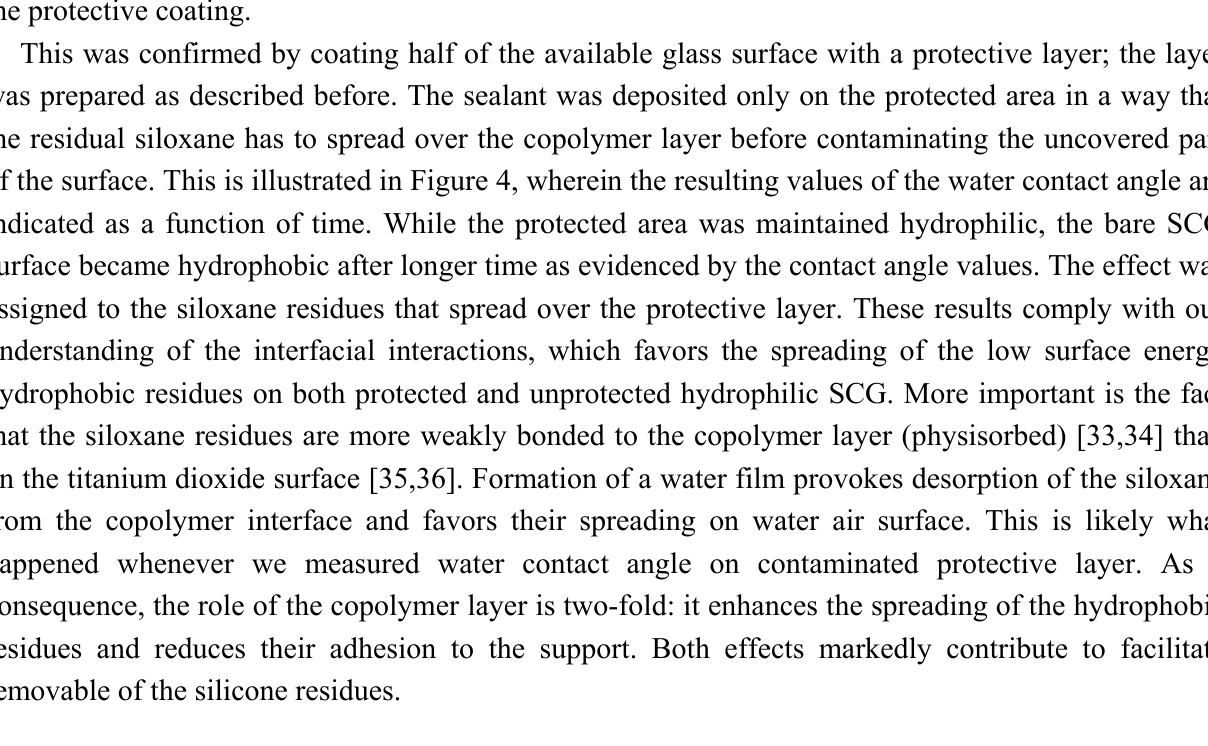
Figure 4. Partially protected SCG contaminated at the end of the protected area (black sealant): contact angles at different times from contamination. The discontinuous line indicates the end of the protective